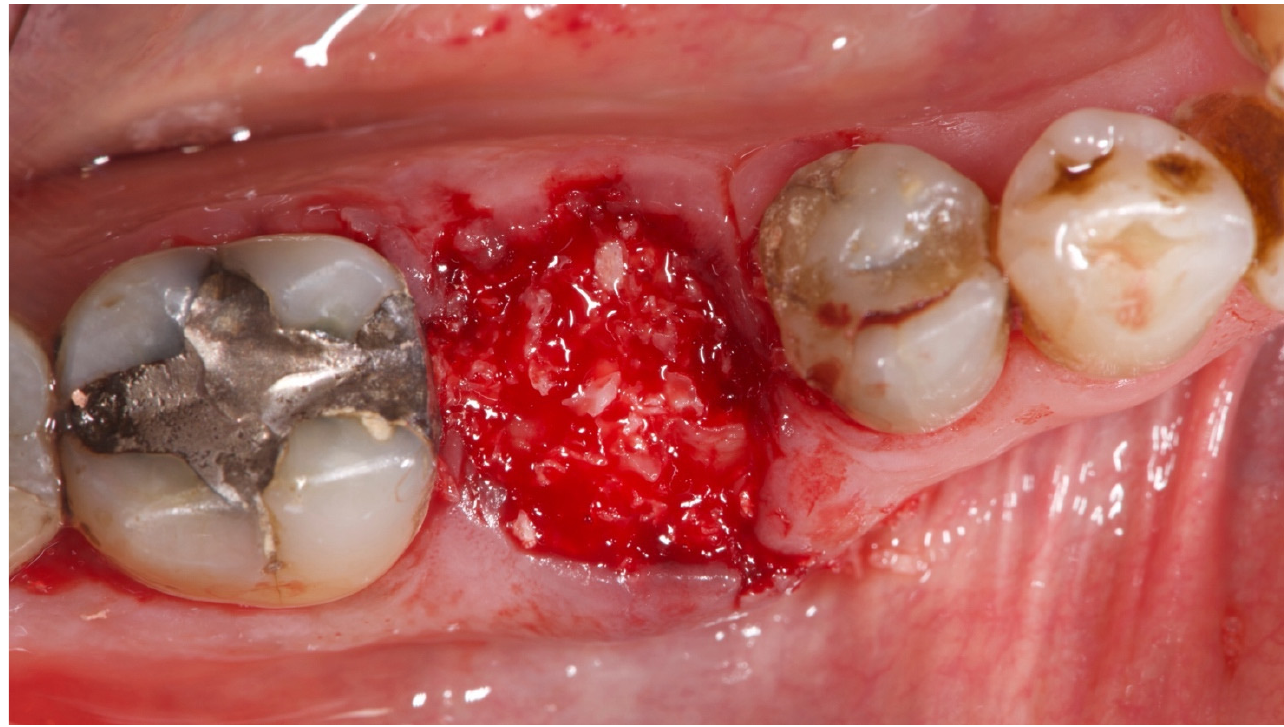
Figure 5. Residual socket grafted with the mixture of L-PRF and bone substitute.